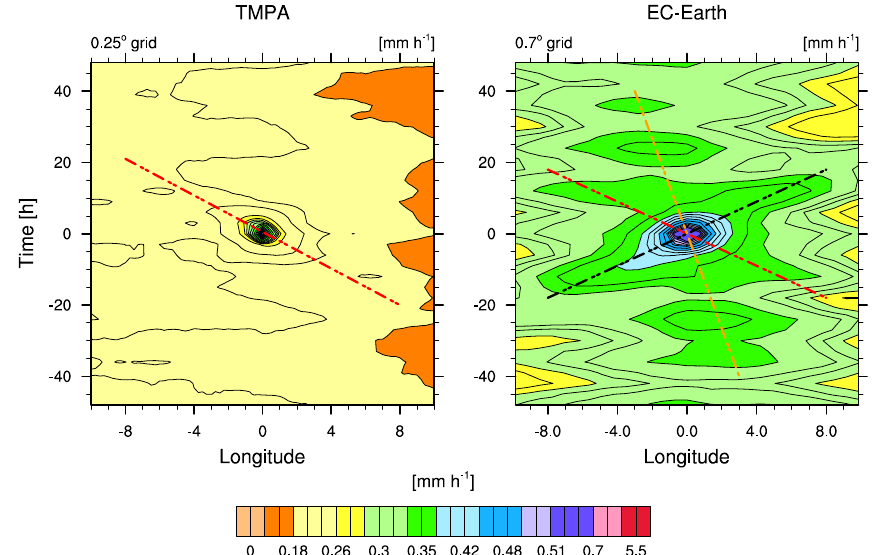
Fig. 7. Hovmöller diagrams of RR centred on composite DC systems, for (left) TMPA observations and (right) EC-Earth simulations. The lines drawn on the figures are visual aids indicating the various directions of motion discussed in the